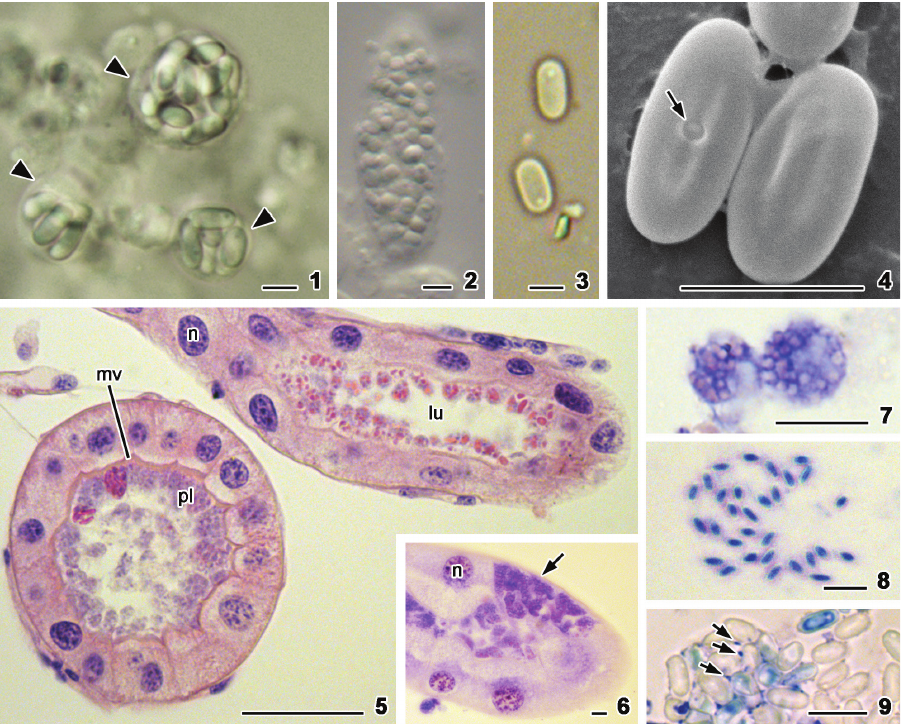
croscopy. 1 Three sporogonial plasmodia with different numbers of included spores. Arrows point to plasma membrane. 2 Merogonial plasmodium with numerous nuclei. 3 Mature spores. 4 The upper surface of the spore possesses a central spore opening (arrow, left spore) while the lower surface of the spore lacks an opening (right spore). 5, 6 Paraffin sections stained with hematoxylin-eosin. Generally, the plasmodia (pl) are found in the lumen of the Malpighian tubule but are often attached to the microvilli (mv) ( 5 ). Rarely, aggregates of vegetative plasmodia (arrow) occur in the epithelial cells of the Malpighian tubules ( 6 ). n = nuclei of epithelial cells. 7–9 Smears of macerated tubules stained with Giemsa depicting vegetative plasmodia ( 7 ), stained young spores ( 8 ), and unstained mature spores with residual nuclei (ar- rows) of the mother sporoplasm. Scale bars: 5 µm ( 1–4 ), 50 µm ( 5 ), 10 µm ( 6–9